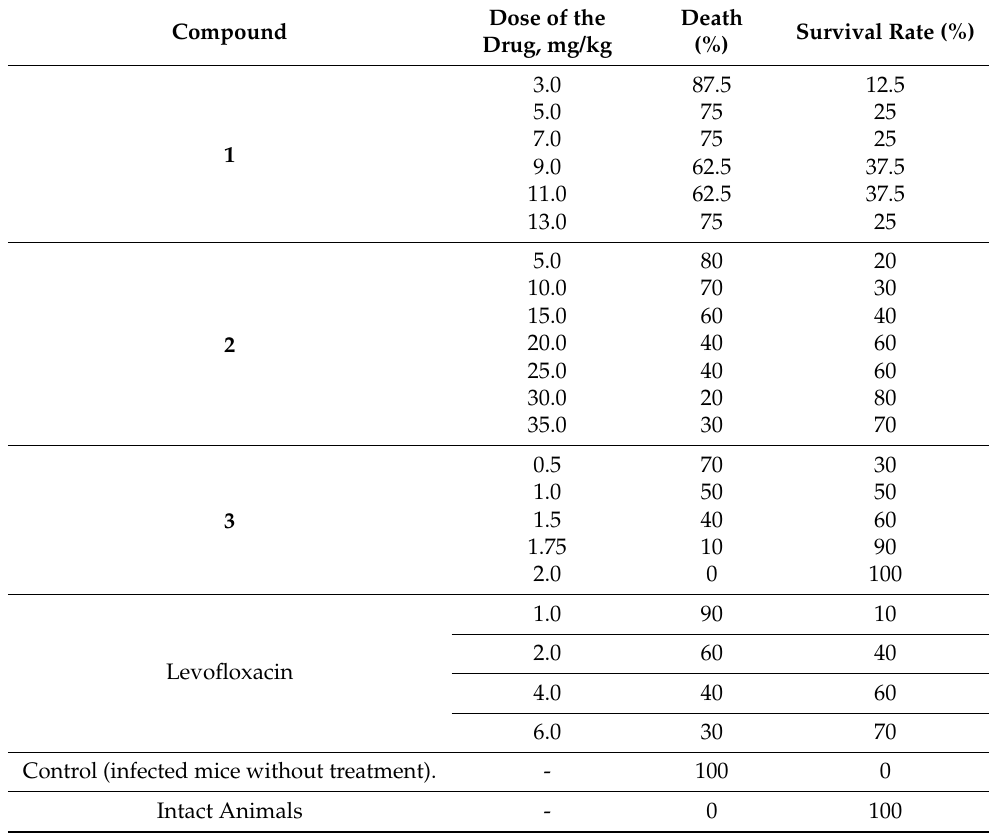
Table 3. Determination of the efficacy of compounds 1 , 2 and 3 in comparison with levofloxacin in a model of staphylococcal sepsis in